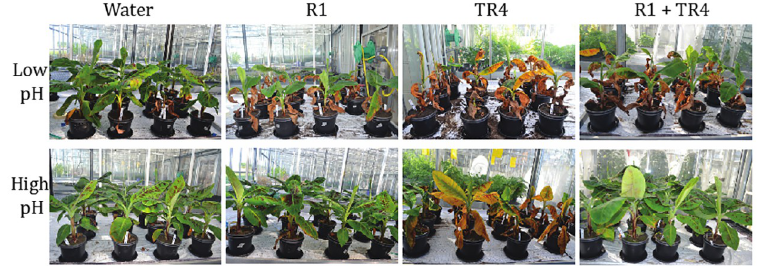
Fig 3. Fusarium wilt symptoms in ‘Grand Naine’ Cavendish banana six weeks after inoculation with R1. F . odoratissimum TR4 and a challenge inoculation (R1 + TR4) at pH 5 (top row) and pH 6 (bottom